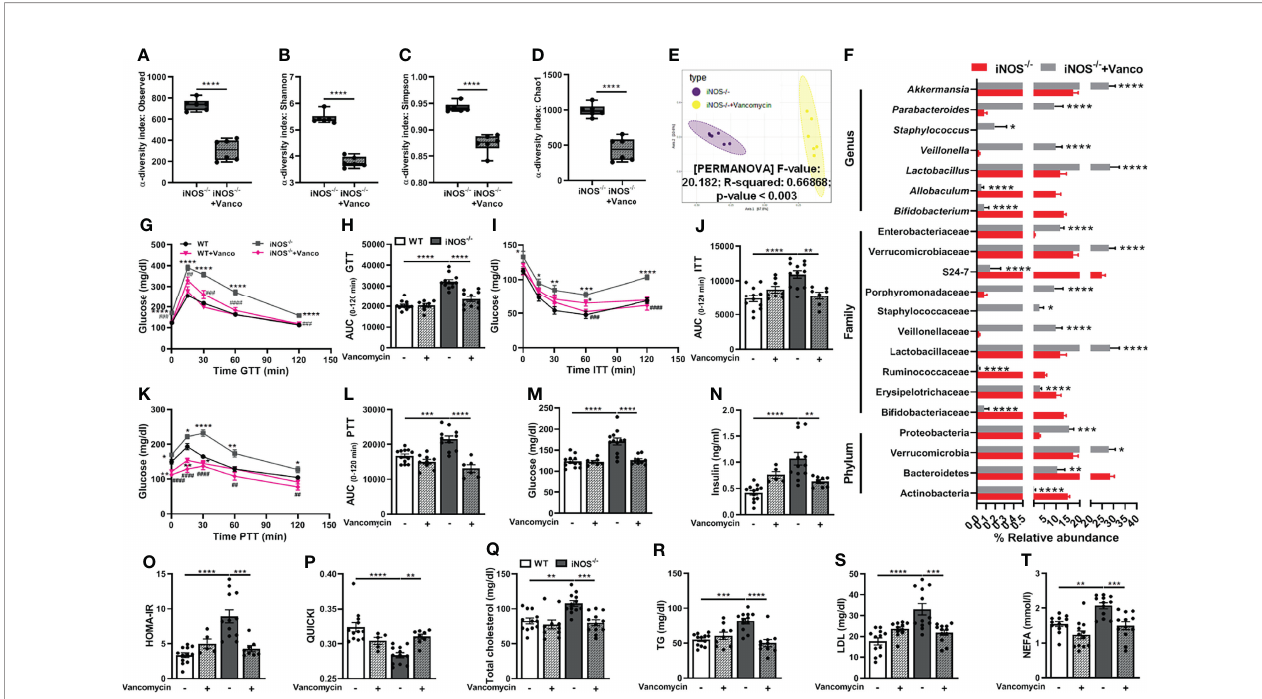
FIGURE 2 | Vancomycin-induced modulation of gut microbiota rescues iNOS − / − mice from systemic IR and dyslipidemia. Gut microbiota analysis in untreated and vancomycin-treated iNOS − / − mice. a -Diversity indices in stool samples: (A) observed, (B) Shannon, (C) Simpson, and (D) Chao1. (E) PCA plot based on the Bray – Curtis distance. (F) Differentially abundant microbiota at the phylum, family, and genus levels. Systemic IR analysis in vancomycin-treated and untreated WT and iNOS − / − mice. (G) Intraperitoneal glucose tolerance test (GTT), (H) area under the curve (AUC) calculated from IPGTT data, (I) intraperitoneal insulin tolerance test (ITT), (J) AUC calculated from ITT, (K) intraperitoneal pyruvate tolerance test (PTT), (L) AUC calculated from PTT, (M) fasting blood glucose levels, and (N) fasting serum insulin levels. Indices of insulin sensitivity: (O) HOMA-IR and (P) QUICKI. Serum lipids: (Q) total cholesterol (TC), (R) triglycerides (TG), (S) low-density lipoprotein (LDL), and (T) non-esteri fi ed free fatty acids (NEFA). Data are represented as mean ± SEM ( n ≥ 6). * p < 0.05, ** p < 0.01, *** p < 0.001, **** p < 0.0001 between indicated groups. ## p < 0.01, ### p < 0.001 and #### p < 0.0001 vs. iNOS − / − . See also Figures S2, S3, S5, S6